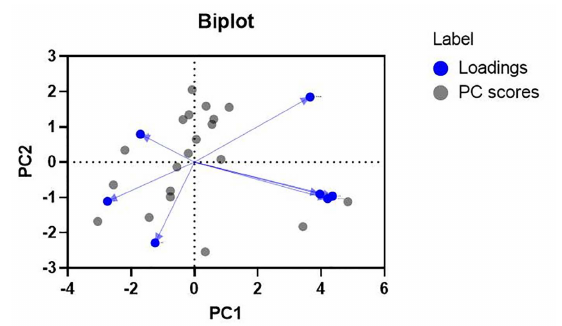
Fig. 4. Results of the PCA analysis for the considered